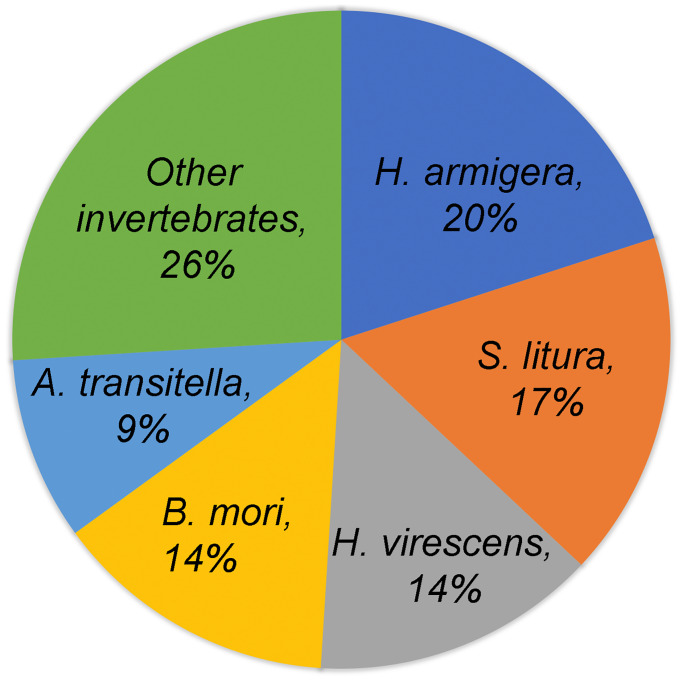
Homology of transcripts to Non-Redundant (NR) protein database.Percentages indicate the distribution of best matches for D. arcuata transcripts to those of other invertebrates based on the homology search conducted with NR db at an e-value cut off of 1e-5. Top 5 hits were Lepidoptera- Helicoverpa armigera, Spodoptera litura, Heliothis virescens, Bombyx mori and Amyelois transitella.